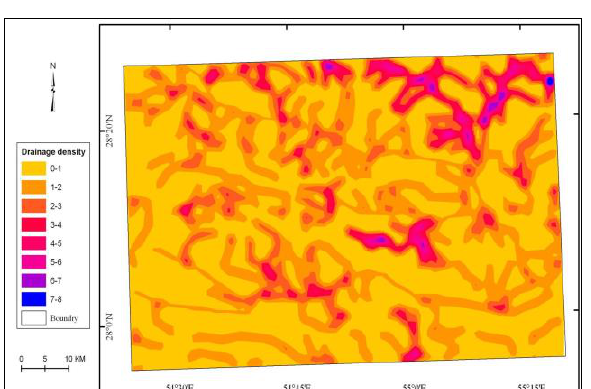
Figure 3. Drainage density of study